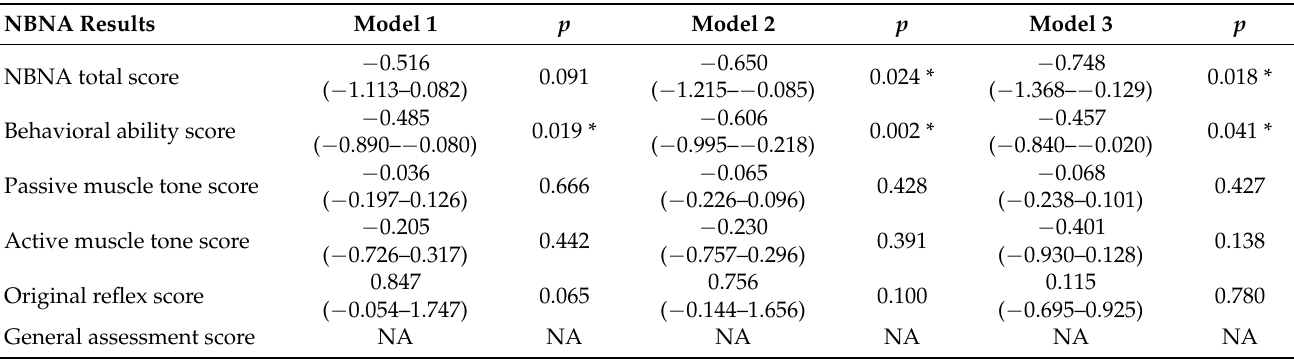
Table 3. The associations of early anemia with neurodevelopment in very low birth weight preterm infants (N =